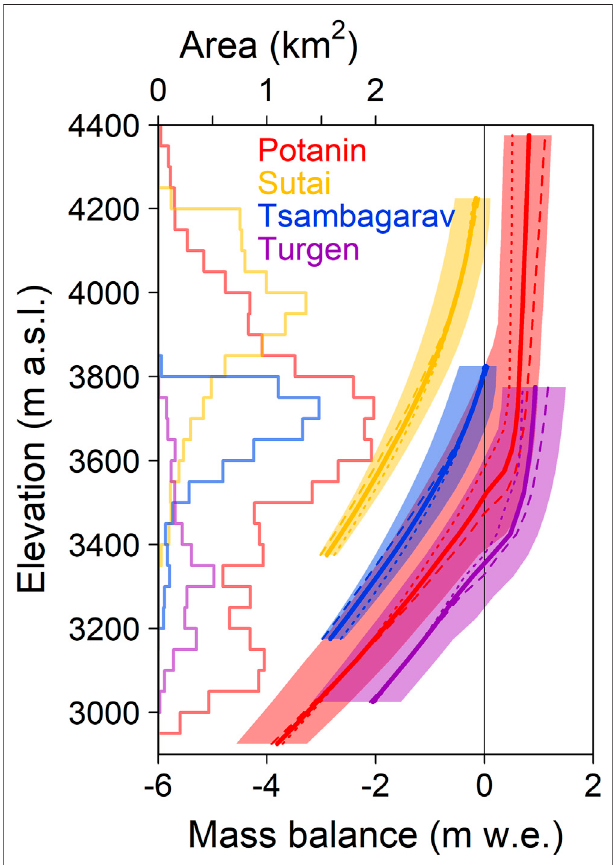
FIGURE 7 | Hypsometry and long-term mass balance pro fi les for Potanin (red), Sutai (yellow), Tsambagarav (blue) and Turgen (purple) glaciers. The stepwise lines denote the hypsometry at 50-m elevation bands. The thick solid lines denote the mean long-term pro fi les (1980 – 2018), and the associated shaded regions represent the ranges for each pro fi le based on the tested precipitation parameters. The dashed lines denote the mass balance pro fi les resulted from precipitation gradients changing between 0 and 90% km − 1 .